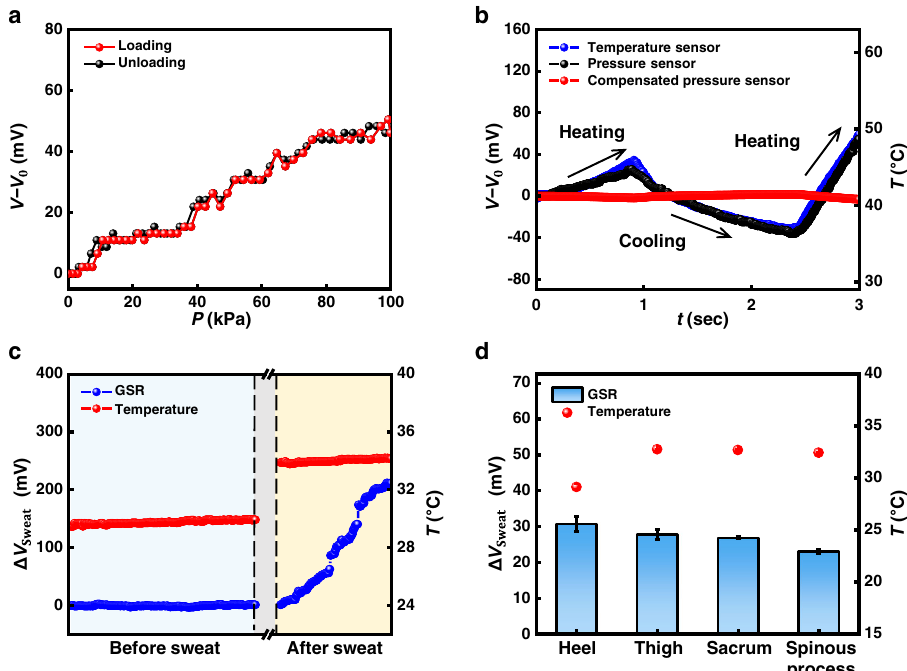
Fig. 4 Performance characteristics of battery-free, wireless multi-modal sensor. a Change in the measured voltage of the pressure sensor under 100 kPa loading/unloading. b Change in the measured voltage of the pressure sensor by temperature variation (heating-cooling- heating) and its compensated signal. c Change in the measured voltage of the GSR and measurement of the temperature against sweat generation. d Change in the measured voltage of the GSR sensor and measurement of the temperature under the different anatomical